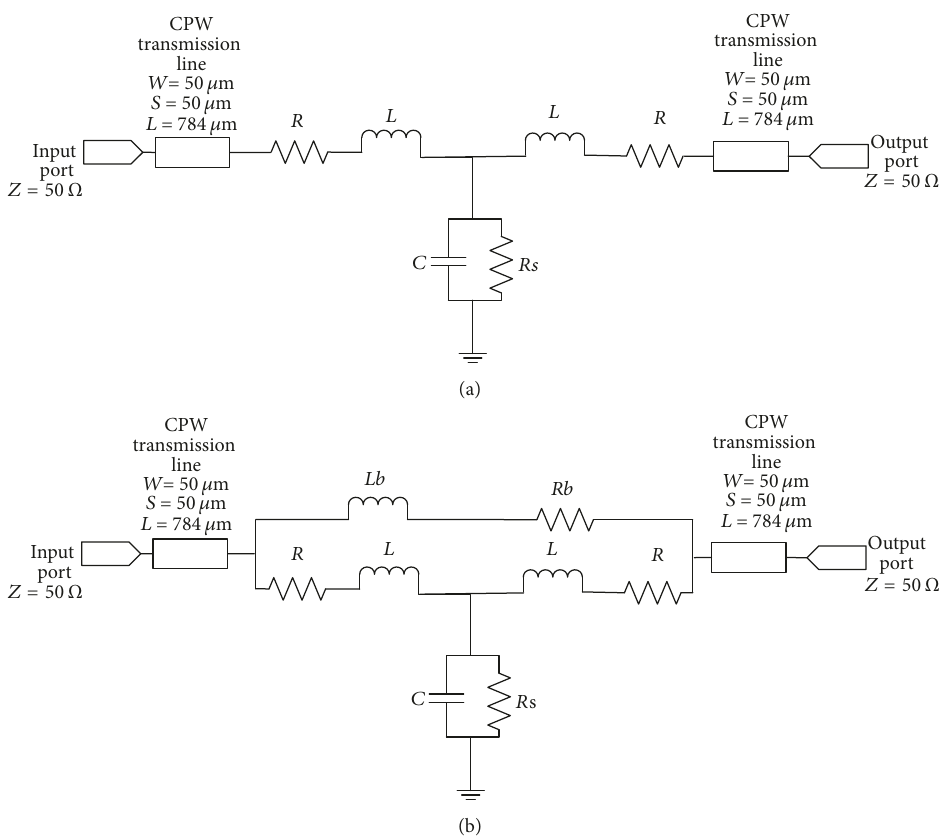
Figure 4: Measured results of 𝑆 21 magnitudes for single line coil inductor structure and dual line coil inductor structure at high temperature (80 ∘ C).